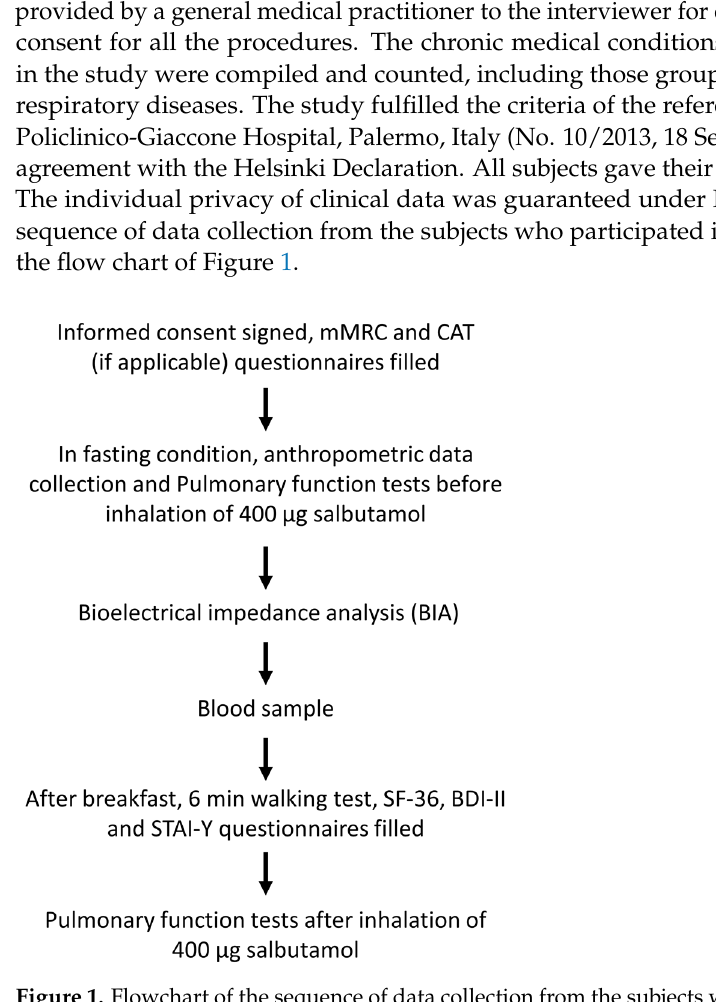
Figure 1. Flowchart of the sequence of data collection from the subjects who participated in the